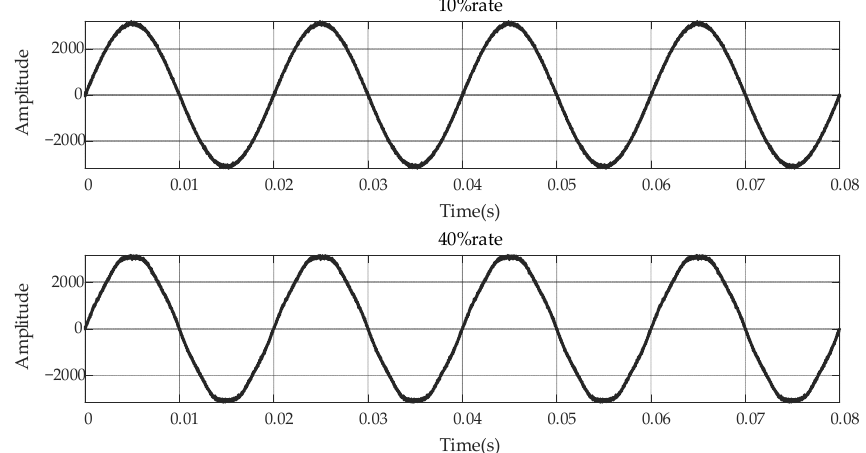
Figure 3. Current signal of low ‐ voltage feeder under different proportions.